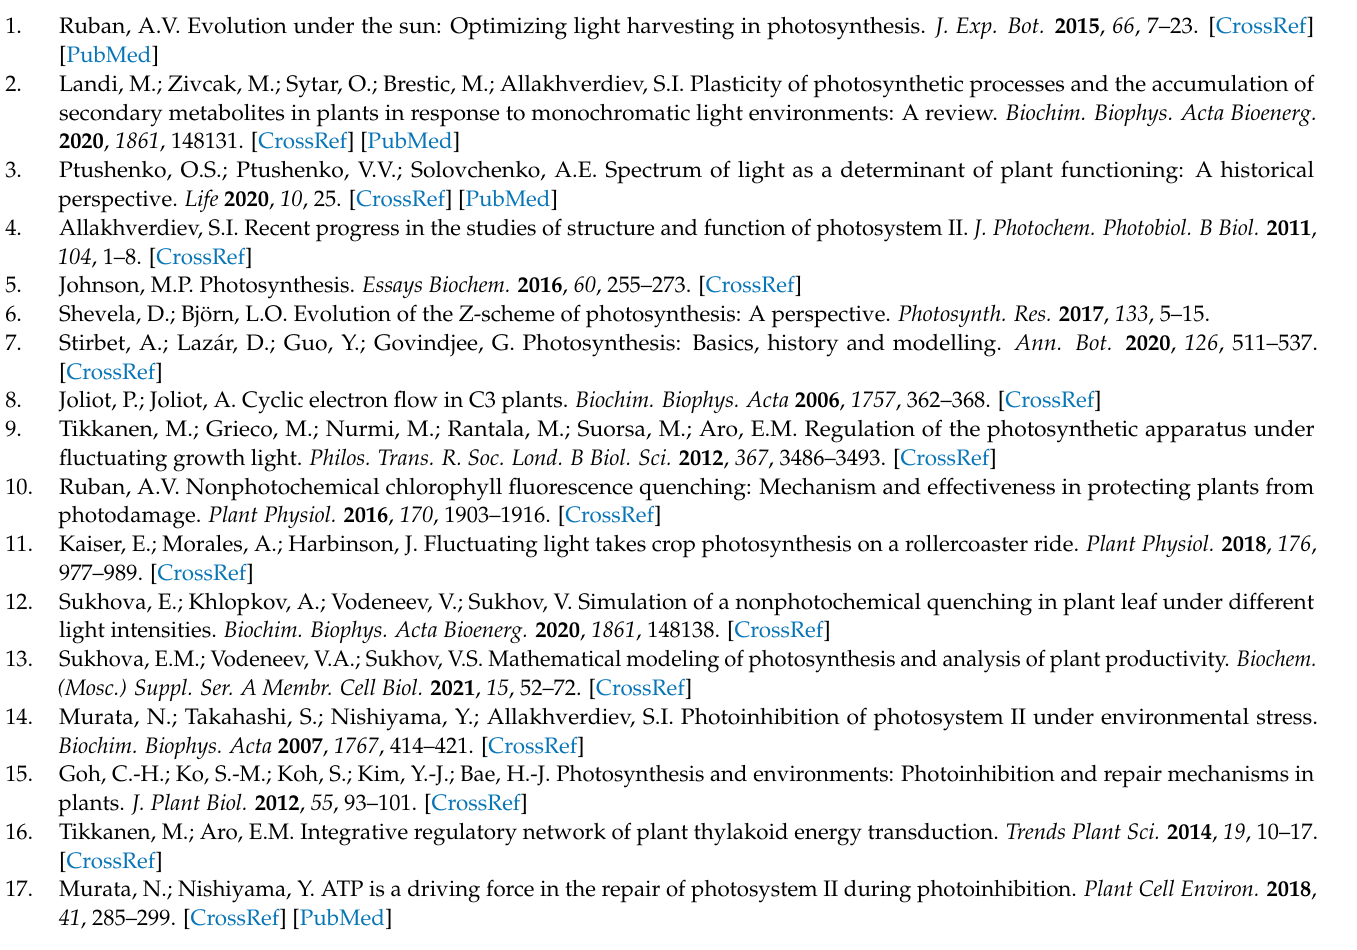
Table S1: List of reflectance indices automatically calculated by the PolyPen RP 410 UVIS software in accordance with [44] and used in the present